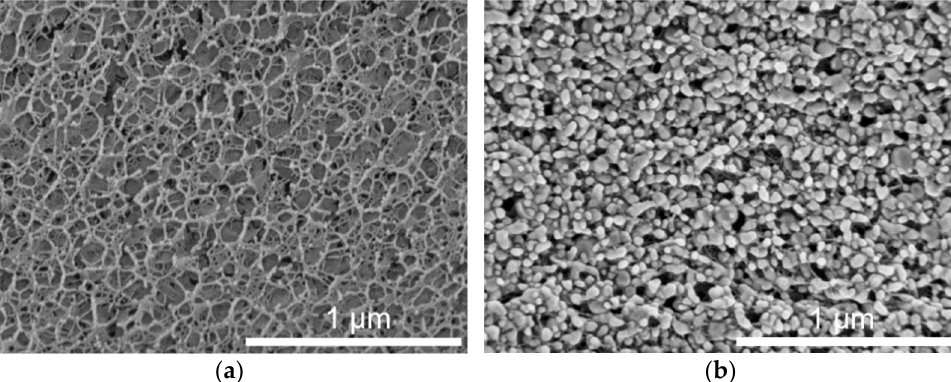
Figure 4. Cryo-SEM cross-sections of hydrogel particles. ( a ) Pure crosslinked alginate matrix. ( b ) Hydrogel particle containing mixed cholesteryl nonanoate–trimyristin dispersion.